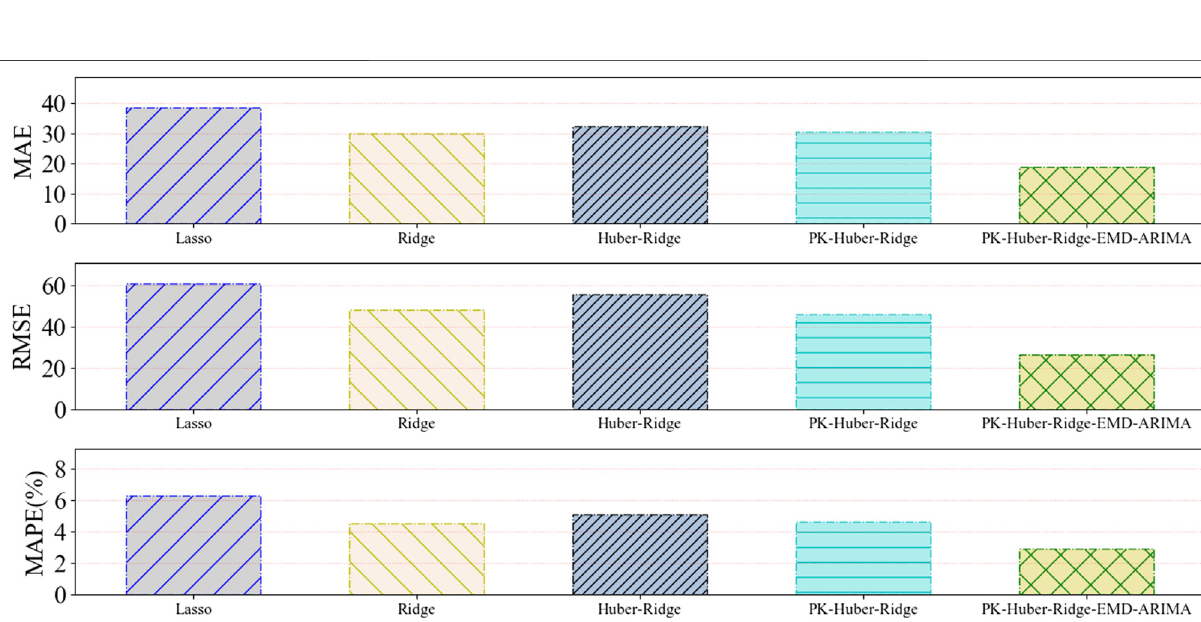
Frontiers in Energy Research |